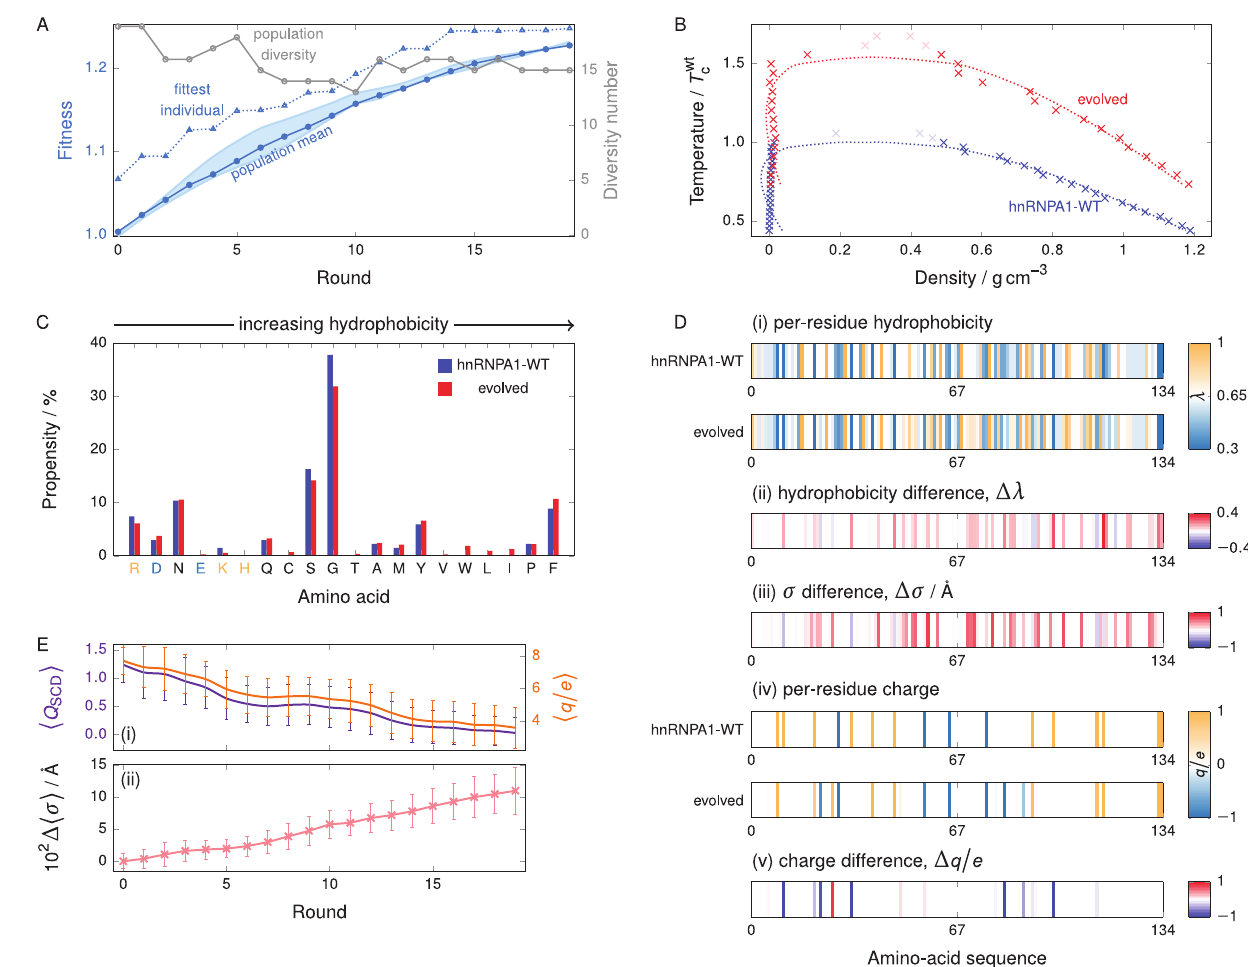
Fig 4. Evolution of hnRNPA1 IDR. (A) Typical GA progression for hnRNPA1. The fitness function [Eq (2)] was evaluated at T ¼ 0 : 57 T wt increases by * 20% over 20 rounds, while maintaining population diversity. The shaded area corresponds to the range of values of the mean fitness obtained from 3 independent genetic-algorithm runs. (B) Comparison of representative phase diagrams before and after genetic-algorithm runs, showing a * 50% increase in critical temperature. Dotted lines are fits, and greyed-out points lie above the critical point, as detailed in Section S1 Text (Sec. S1-b). (C) Amino-acid composition before and after using a genetic algorithm to increase the phase diagram width for hnRNPA1, revealing the appearance of hydrophobic amino acids, while no bias against charged or polar amino acids is observed. Amino acids are plotted in order of increasing hydrophobicity [see Table A in S1 Text]. Positively charged amino acids are indicated in light orange and negatively ones in light blue. (D) Map of (i) the per-residue hydrophobicity along the sequence, (ii) the change from WT hnRNPA1 to the evolved protein, (iii) the per-residue change σ value and (iv), (v) analogous maps for the charge. The data for the evolved protein are averaged over the entire population at the end of 3 independent genetic-algorithm runs. Partial charges reflect only partial carriage in the population. Some charges have appeared and some have disappeared; the overall balance is towards charge neutralisation. (E) (i) The sequence charge decoration (SCD) and the charge number ( q / e ) of the population decrease over the course of the genetic- algorithm run, indicating an evolutionary charge neutralisation. (ii) The average σ value of the amino acids in the population increases over the course of the genetic-algorithm run. Error bars are standard deviations of the averaged σ value of individual sequences with respect to the population.